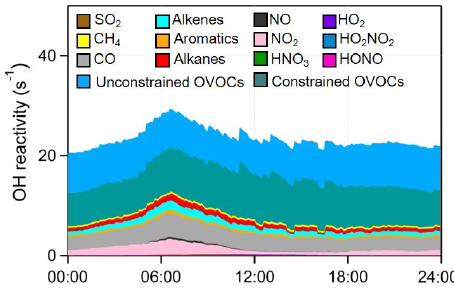
Figure 10. Model-calculated average OH reactivity ( K OH ) and its breakdown to the major reactants during the summertime O 3 pollu- tion